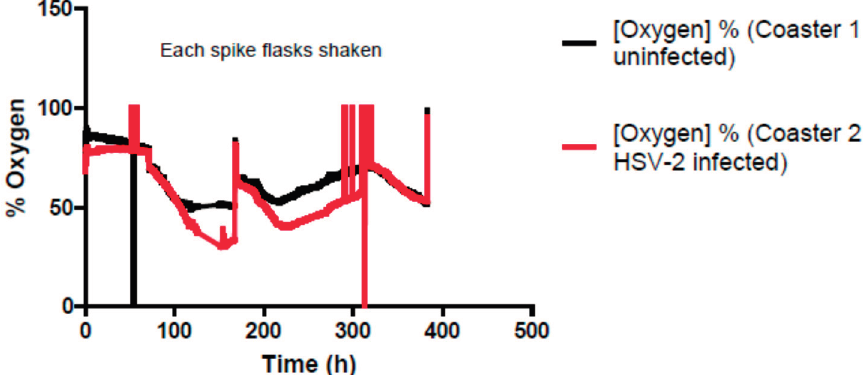
Figure 2. HSV-2 infection monitoring of sensor patches. Each spike in the figure indicates a BSL-3 visit was made to replenish cells and collect an aliquot of culture supernatant for HSV-2 titer